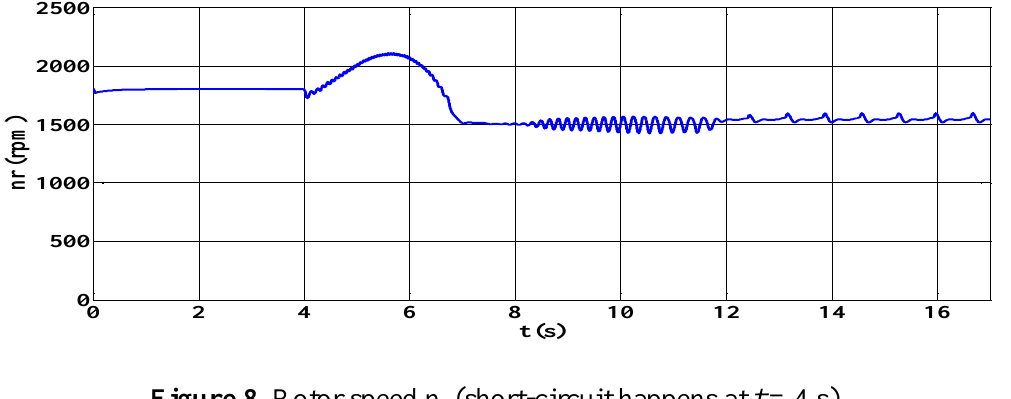
Figure 8. Rotor speed n r (short-circuit happens at t = 4 s).